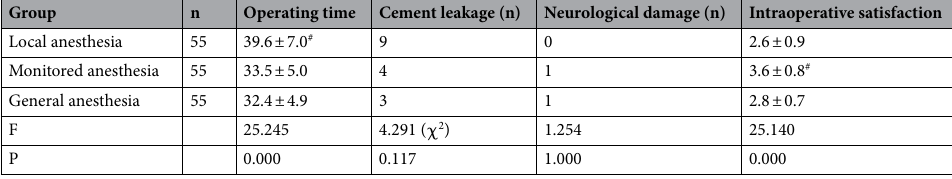
Table 3. Operating time, the rate of cement leakage, neurological damage. # Statistical difference among three groups (P < 0.05). One-way ANOVA was used in three group comparisons with univariate data. Enumeration data (cement leakage) was compared using chi-square test; Enumeration data (neurological damage) was compared using Fisher’s exact test. F: F test value.